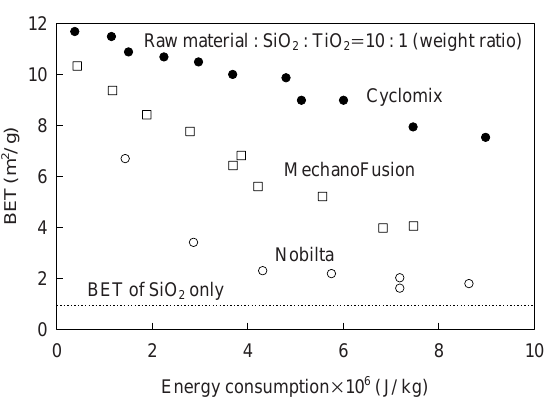
material : SiO 2 : TiO 2 (cid:3) 10 : 1 (weight ratio)